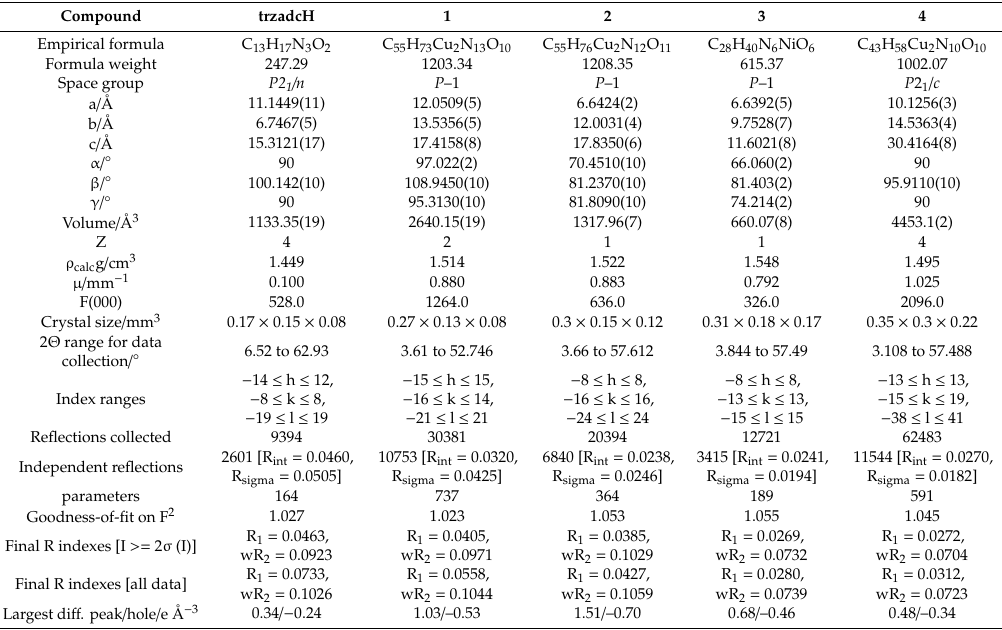
Table 3. Crystallographic data of the ligand trzadcH and the complexes 1 – 4 .